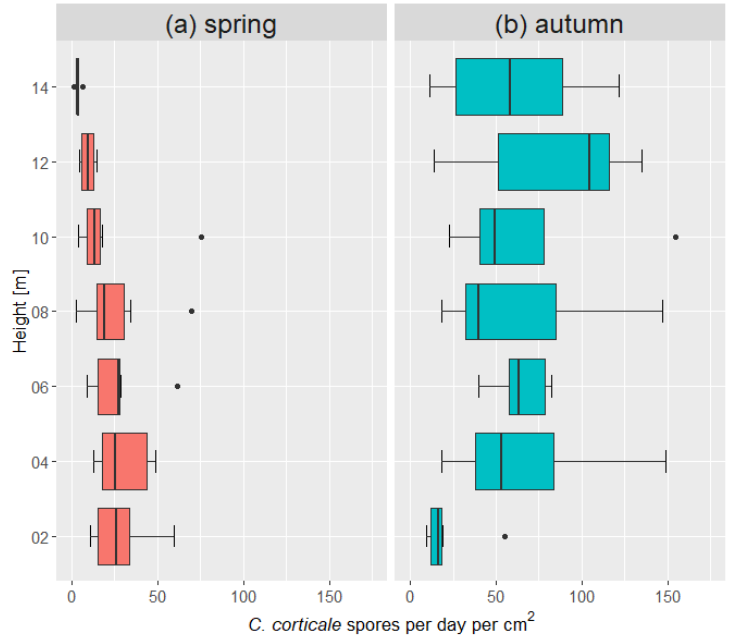
Figure 4. Abundances of spores of C. corticale per day per cm 2 along the vertical gradient at the height from 2 to 14 m in the study site close to Wuerzburg in ( a ) spring (7 March–2 May 2019), and ( b ) autumn (17 October–17 December 2019); box plots: central line: median, boxes: second and third quartile, whiskers: interquartile range, dots: outliers; n = 6.